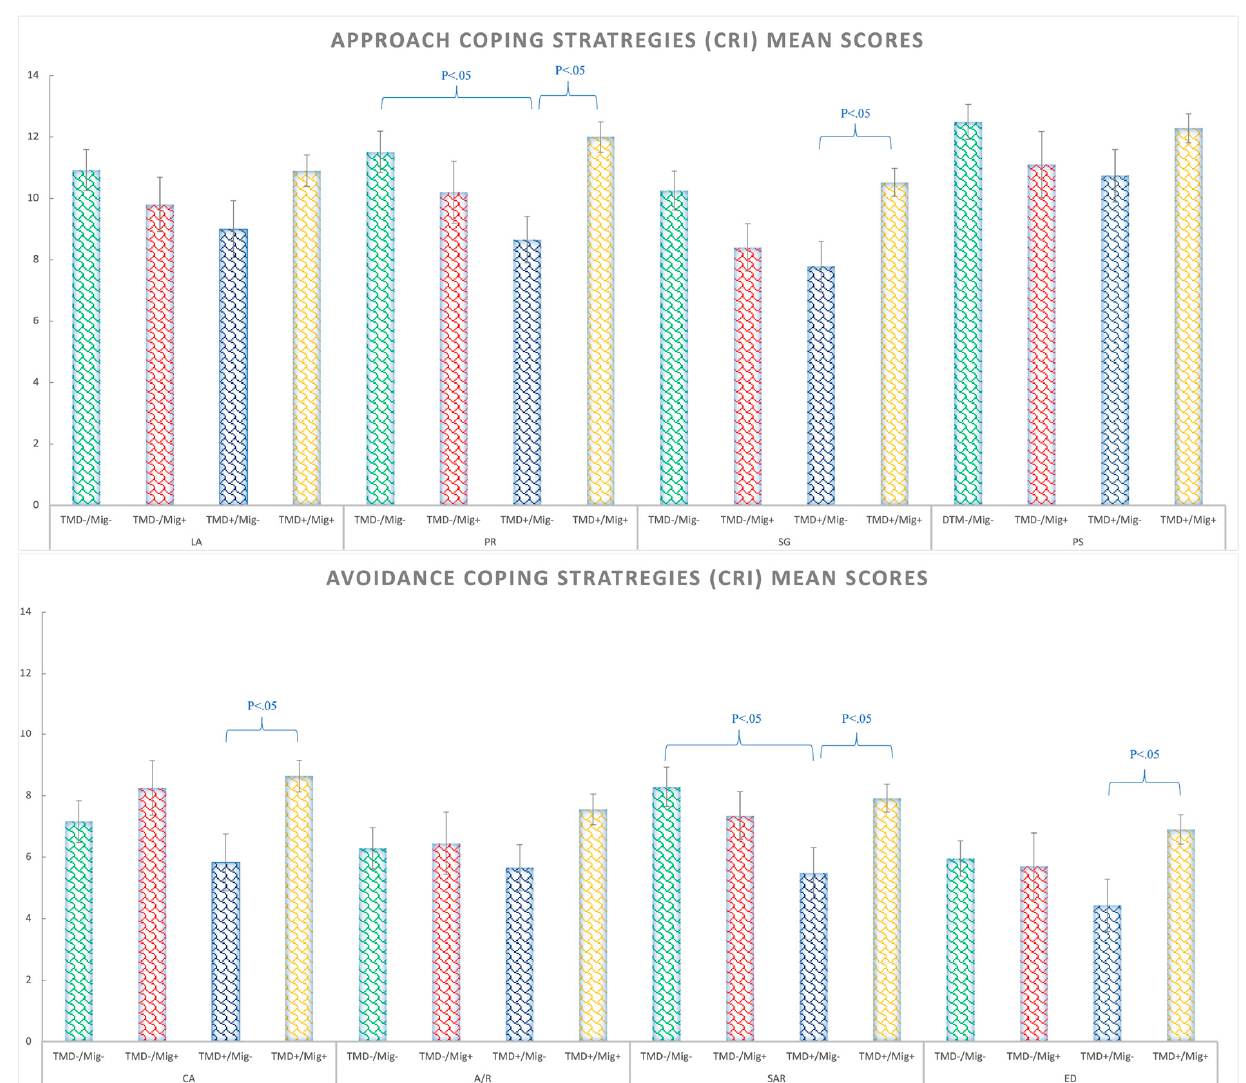
Figure 4. Coping strategies (CRI) mean scores for approach strategies (above) and avoidance strategies (bellow) in the TMD − /Migraine − , TMD − /Migraine+, TMD+/Migraine − , TMD+/Migraine+ groups. Abbreviations: logical analysis (LA), positive reappraisal (PR), seeking guidance and support (SG), problem solving (PS), cognitive avoidance (CA), acceptance or resignation (A/R), seeking alternative rewards (SAR), and emotional discharge (ED).